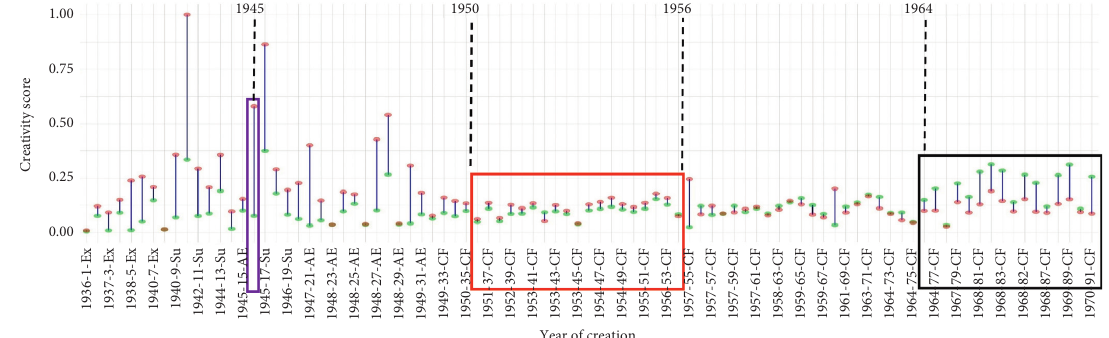
Figure 15: N network based on IR . 91 paintings by Mark Rothko. Green points correspond to the creativity scores of the full dataset (161 3 5 paintings). Labels contain the style abbreviation of every artwork as follows: Ex: Expressionism, Su: Surrealism, AE: Abstract Expressionism, and CF: Color Field Painting. Red points correspond to the creativity scores of Rothko’s artworks without external influences. Purple box corresponds to Rothko’s Primeval Landscape from 1945. Red box corresponds to paintings from the period between 1951 and 1956. Black box corresponds to late paintings from 1964 to